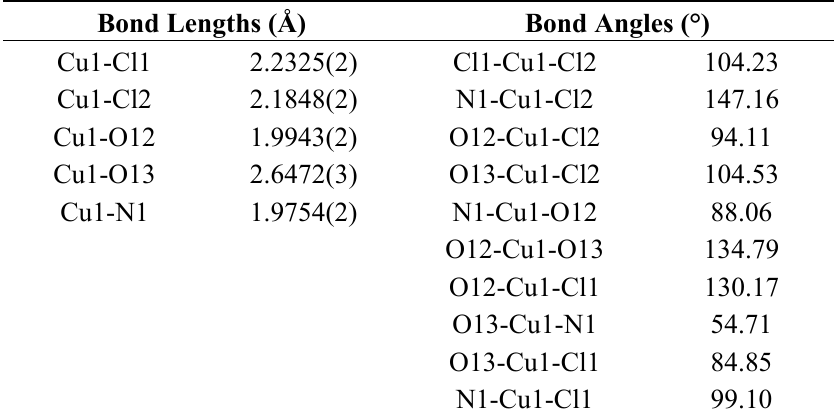
Table 3. Selected bond lengths and bond angles in copper complex 6a .